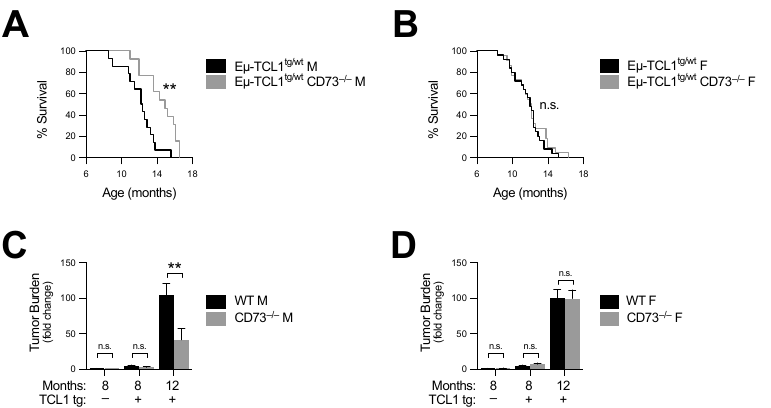
Figure 2. CD73 deficiency prolongs survival of Eµ-TCL1 tg/wt males. Eµ-TCL1 tg/wt mice were crossed with CD73 − / − mice and leukemia progression was analyzed. ( A , B ) Survival of Eµ-TCL1 tg/wt ( n = 14 M and 25 F) and Eµ-TCL1 tg/wt CD73 − / − ( n = 13 M and 22 F) ( a ) males and ( B ) females. ( C , D ) Fold change in peripheral disease burden of Eµ-TCL1 tg/wt and Eµ-TCL1 tg/wt CD73 − / − ( C ) 8- and 12-month-old male and ( D ) female mice relative to 8-month-old hWT mice (hWT n = 5 M and 5 F; hCD73 − / − n = 7 M and 5 F). Means +/ − SEM are shown (** p < 0.01 by log-rank ( A , B ) or Mann–Whitney test ( C , D )). F, female; M, male; tg, transgenic; n.s., non-significant. Table 1. Median survival time of experimental groups of Eµ-TCL1 tg/wt transgenic mice. Experimental Group